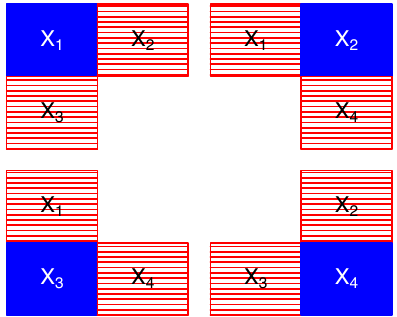
Figure 1. Graphical representation of a 2 × 2 lattice and elements of x .